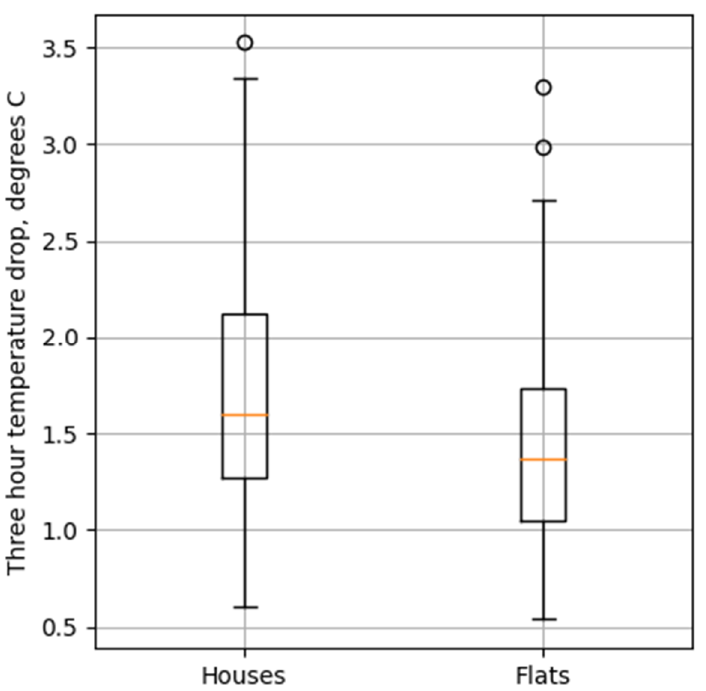
Figure 5. Three-hour temperature drop of flats and houses. Median shown by orange lines, inter- quartile range shown by boxes, Q1—1.5*Q1 and Q3 + 1.5*Q3 shown by whiskers. tile range shown by boxes, Q1—1.5*Q1 and Q3 + 1.5*Q3 shown by